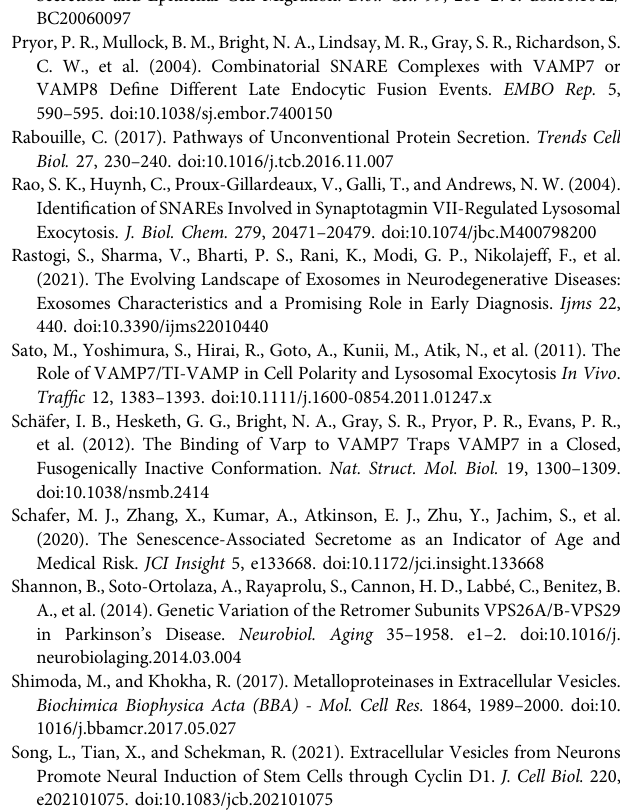
Table 1. Cold Spring Harb. Perspect. Biol. 7, a020628. doi:10.1101/cshperspect.